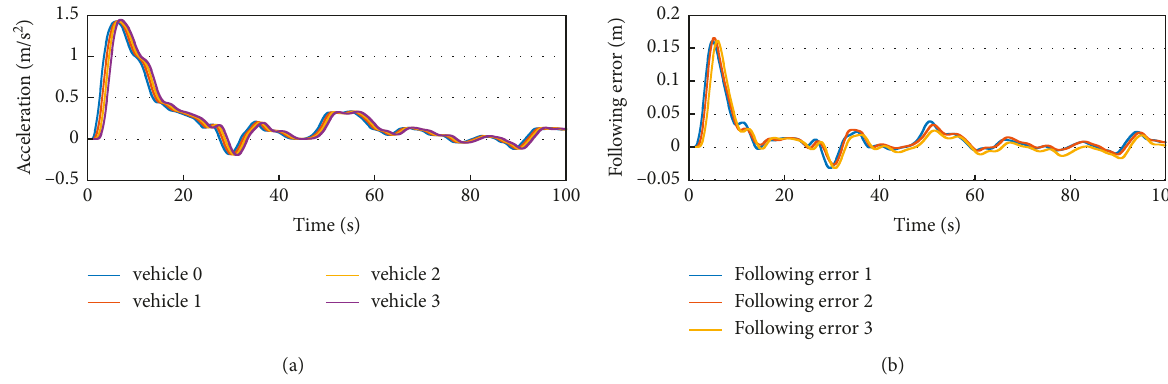
Figure 17: The simulation results of SPC with estimation deviation.